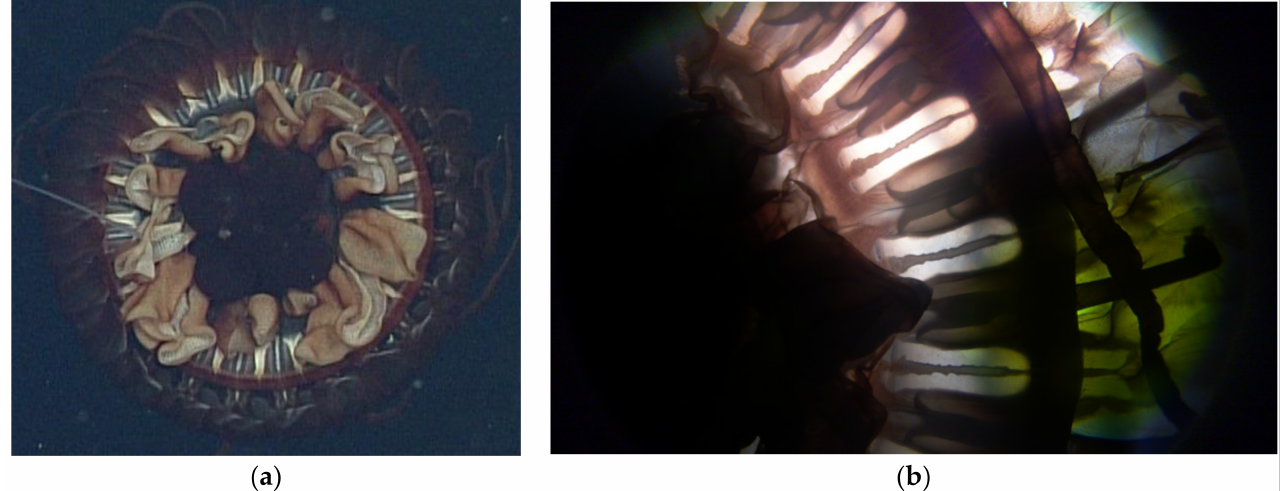
Figure 7. ( a ) In situ image of Atolla gigantea (D915) showing what appears to be divergent septa and ( b ) a photograph of the same specimen preserved in 5% formalin showing what appear to be straight septa. This specimen was 7.6 cm in diameter.